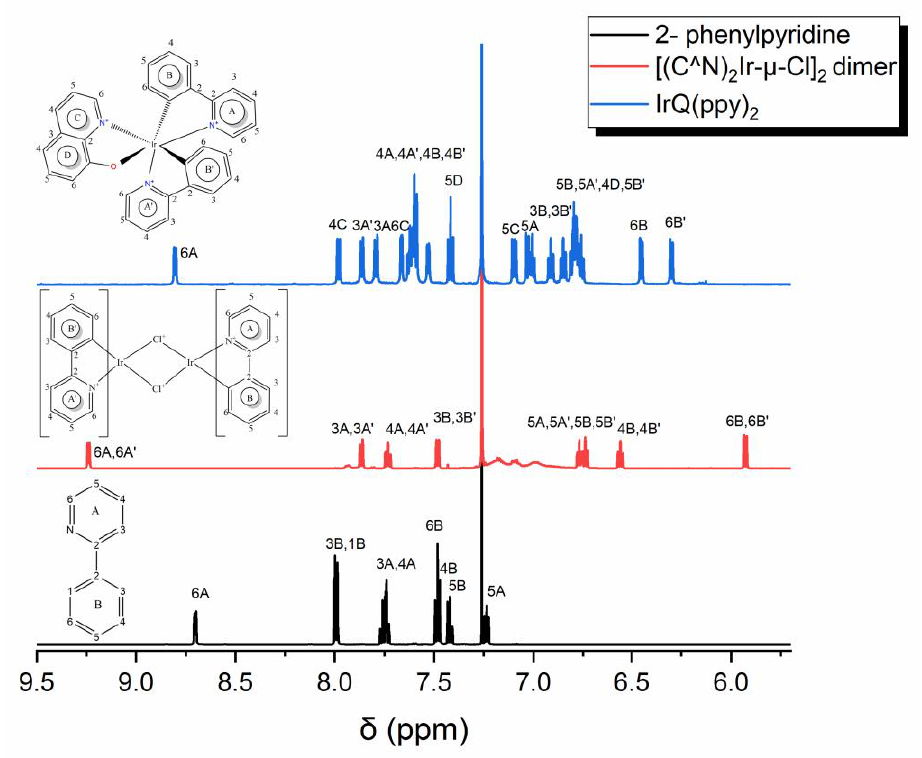
Figure 6. Nuclear magnetic resonance ( 1 H NMR) spectra of 2-phenylpyridine, dimer and complex.